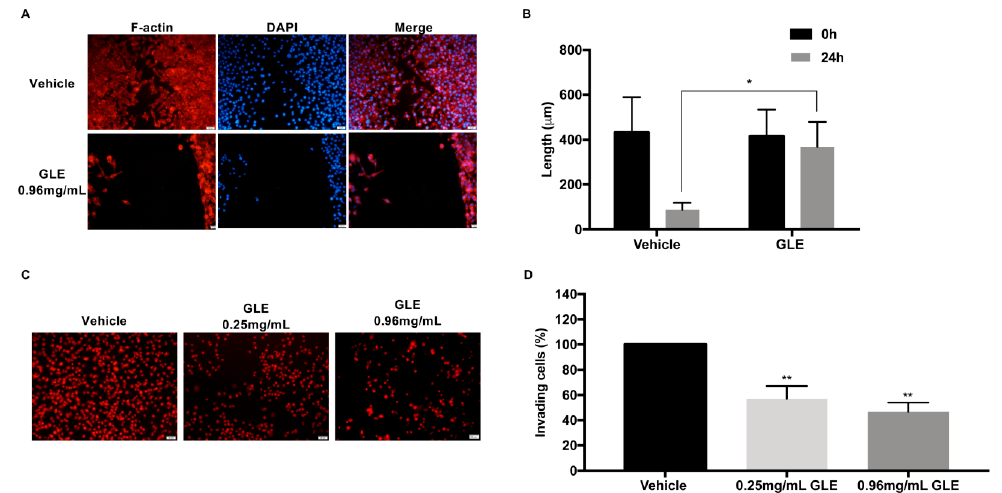
Figure 2. GLE decreases the migration and invasion of MDA-MB-231 breast cancer cells. ( A , B ) MDA-MB-231 (2 × 10 4 ) cells were seeded onto two-well silicone insert with a defined cell-free gap wound healing assay plates and grown in 5% FBS media before treatment with vehicle (0.1% DMSO) or GLE (0.96 mg/mL) for 24 h. Cells were fixed and stained with rhodamine phalloidin and DAPI as described in materials and methods. We quantified 36 micrographs that were taken at a magnification of 20X. The migratory effect of the cells was quantified by measuring the distance between the edges of the wound with ImageJ V.1.50i. ( C , D ) Quiescent MDA-MB-231 (7.5 × 10 4 ) cells were seeded in Transwell ® chambers and treated with vehicle, 0.25 mg/mL, and 0.96 mg/mL GLE for 24 h. Cells were fixed and PI-stained. The invasion ability of the cells was quantified by counting the number of cells that invaded through the extracellular matrix. Approximately, 36 micrographs were taken at a magnification of 20X and quantified using ImageJ. Data are expressed as mean ± SEM. Experiments represent data obtained from three independent biological replicates. Statistically significant differences are shown at * p < 0.05, ** p < 0.01 compared to vehicle. Scale bars = 20 μ m.